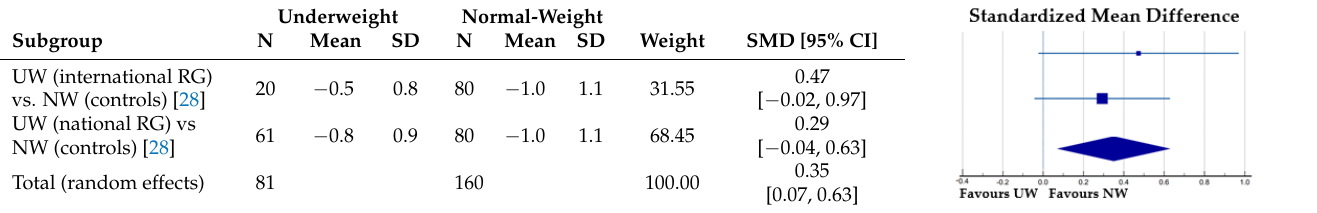
Table 5. BID by weight status in female athletes.